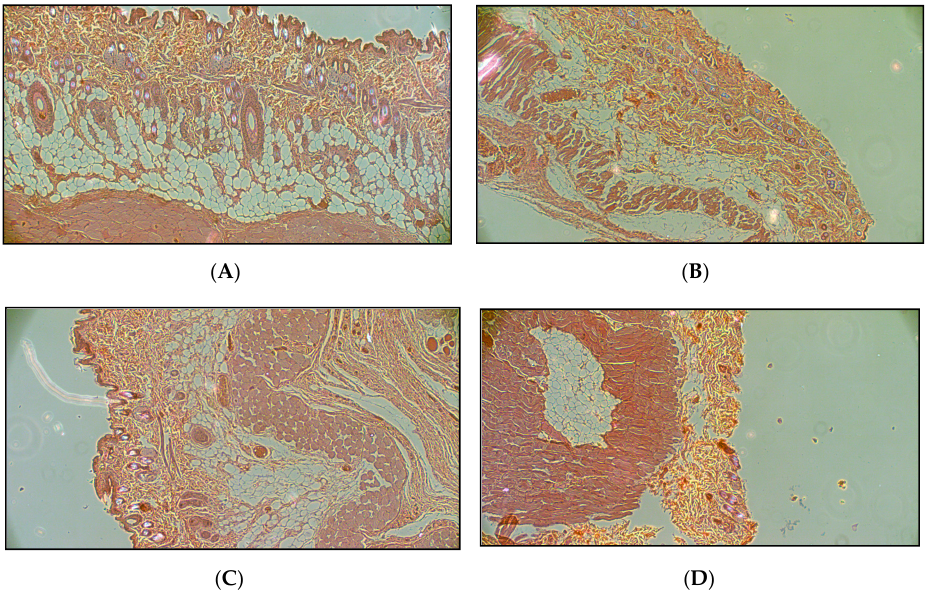
Figure 9. Histological structure of native and sensitized rat and mouse abdominal skin preparations (Hematoxylin-Eosin staining). ( A ): native rat skin (0 tape-stripping), ( B ): native mouse skin (0 tape-stripping), ( C ): sensitized (10 tape-strippings) rat skin, ( D ): sensitized (10 tape-strippings) mouse skin.